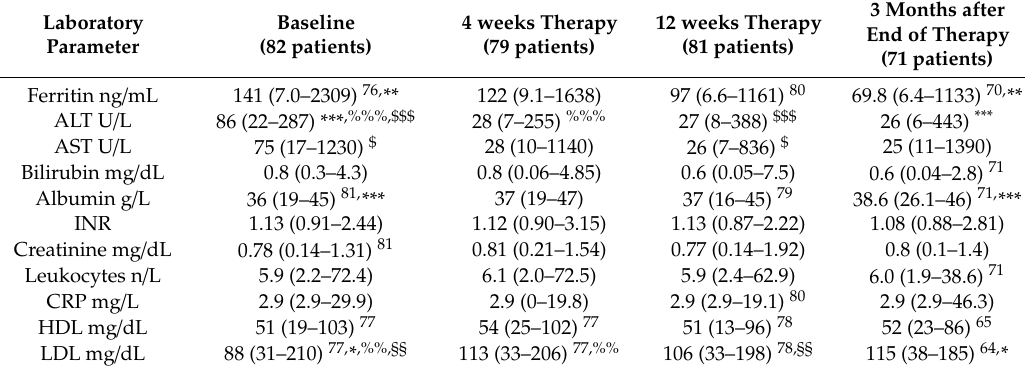
(Table 1). The positive association with albumin 4 and 12 weeks after the start of DAA therapy disappeared at 3 months after the end of treatment (Table